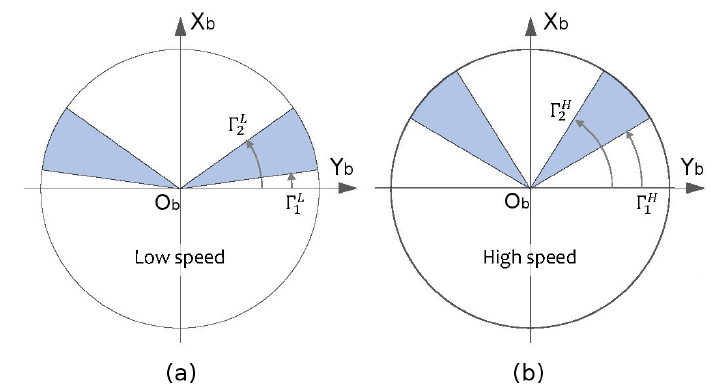
Figure 6. Obstacle avoidance sectors. ( a ) Definition for low speed mode. ( b ) Definition for high speed